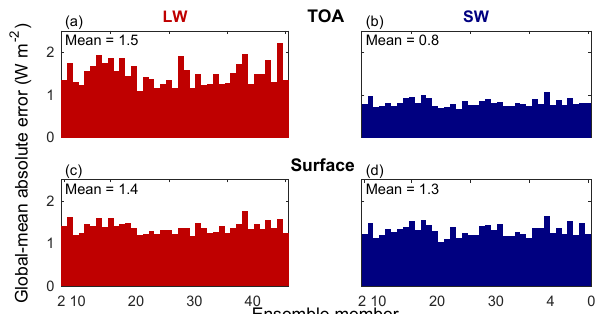
Figure 4. Validation across ensemble members. Global-mean abso- lute error of kernel-estimated clear-sky radiative flux change from 2006 to 2096 for members 2–40 of the CESM1 large ensemble for LW (a, c) and SW (b, d) fluxes at the TOA (a, b) and surface (c, d) .